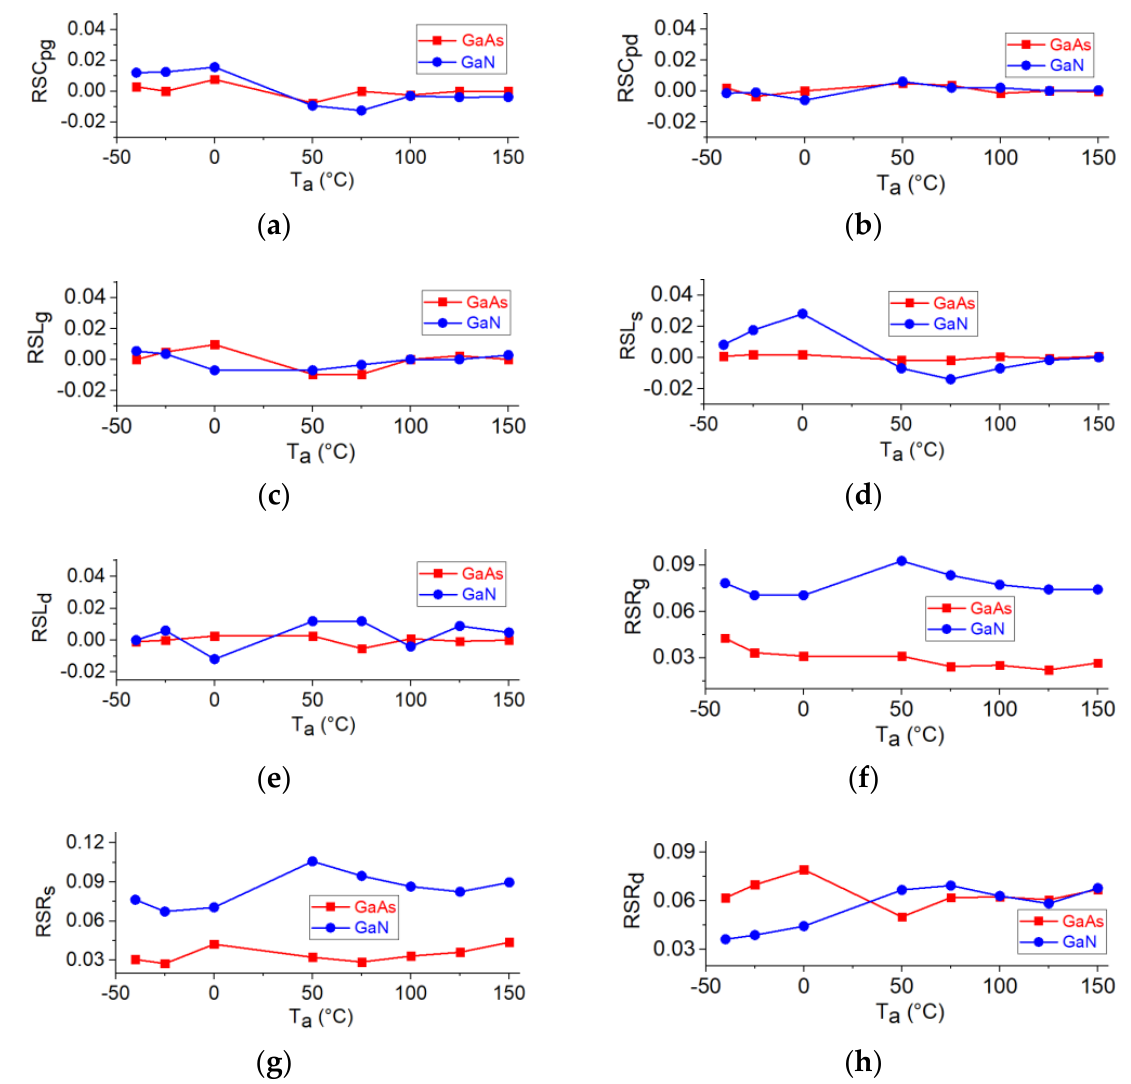
Figure 9. Behavior of the relative sensitivities of the extrinsic parameters versus T a for the two studied devices.